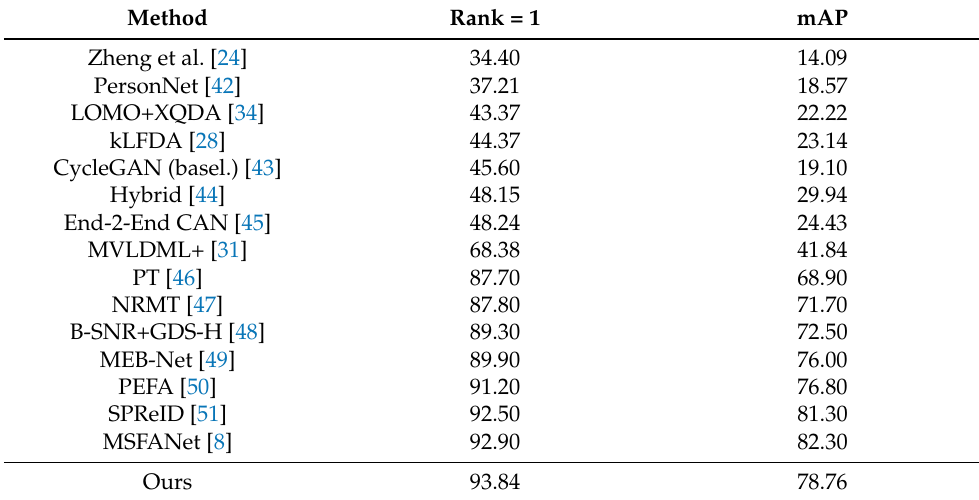
Table 4. Experimental results on